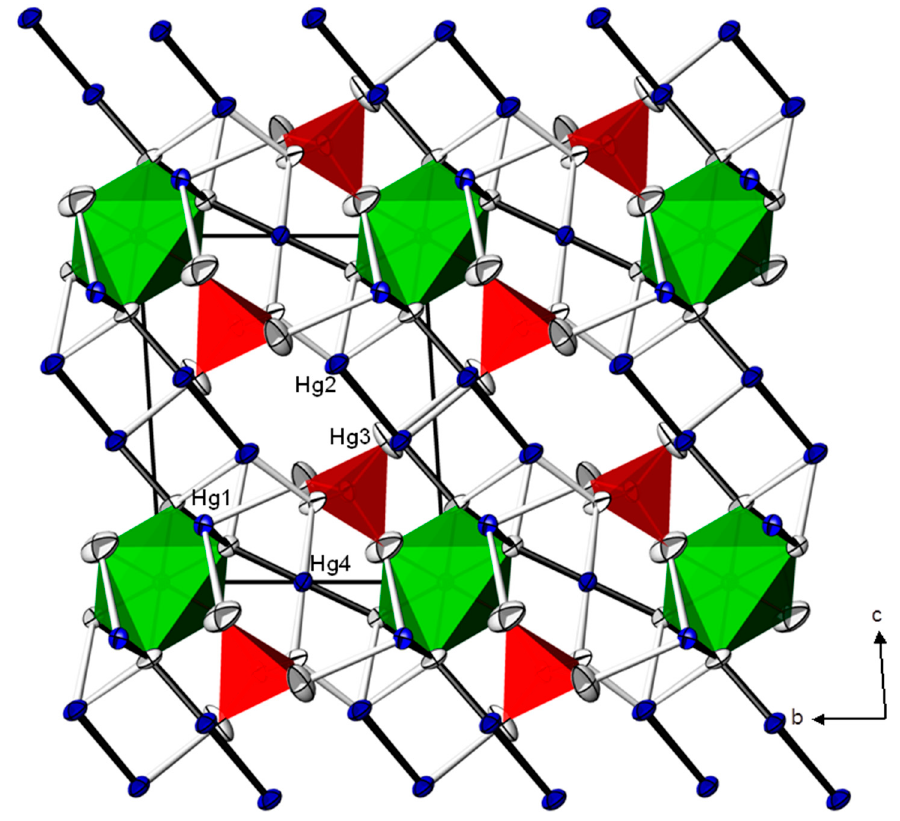
Figure 2. Crystal structure of Cd(Hg I 2 ) 2 (Hg II ) 3 O 4 (CrO 4 ) 2 emphasizing the layered arrangement of the Hg–O network and the [CdO 6 ] (green) and CrO 4 (red) polyhedra. Displacement ellipsoids are as in Figure 1.